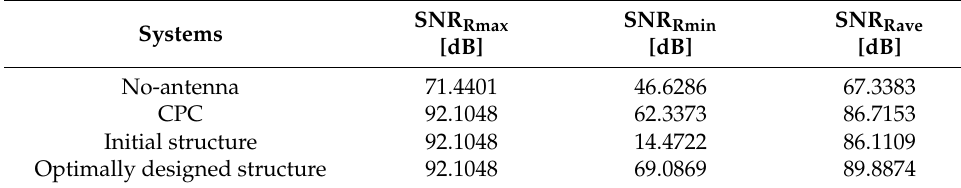
Table 12. Signal-to-noise ratio comparison of different antenna